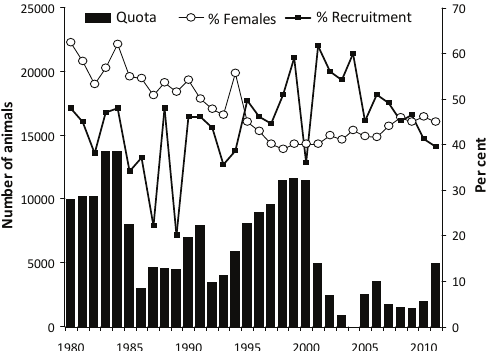
Figure 4. Hunting quotas (number of animals) in year N and estimates of percent recruitment rates (calves per 100 females 1 yr+) and percent females 1 yr+ in the breeding herd in year N - 1. Data for recruitment rate and female proportion of the breeding herd are from Solberg et al. (2012) and twenty annual NINA reports (1991-2011) in the journal